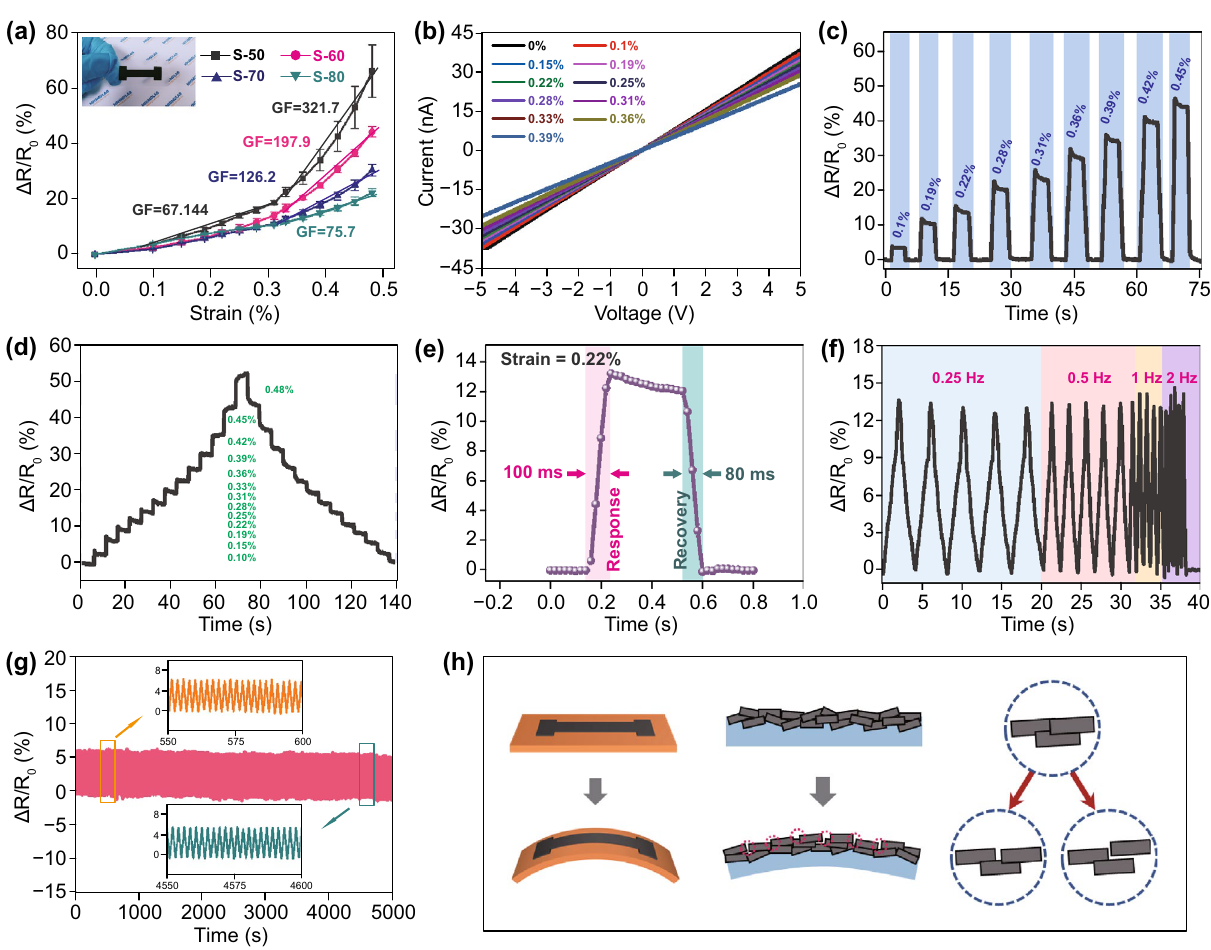
Fig. 3 a Response vs strain curves of S-50/60/70/80 sensors. b I–V curves of the S-50 sensors under strains from 0 to 0.39%. c Dynamic response curves of S-50 sensor under various applied strains. d Dynamic response curve under a stair-like strain change. e Fast response and recovery speed of S-50 sensor. f Relative resistance variations under cyclic loading–unloading with a strain of 0.19% at the frequency of 0.25 to 2 Hz. g Current–time curves of the S-50 sensor for 5000 loading/unloading cycles with an applied strain of 0.25%. h Schematic diagram of